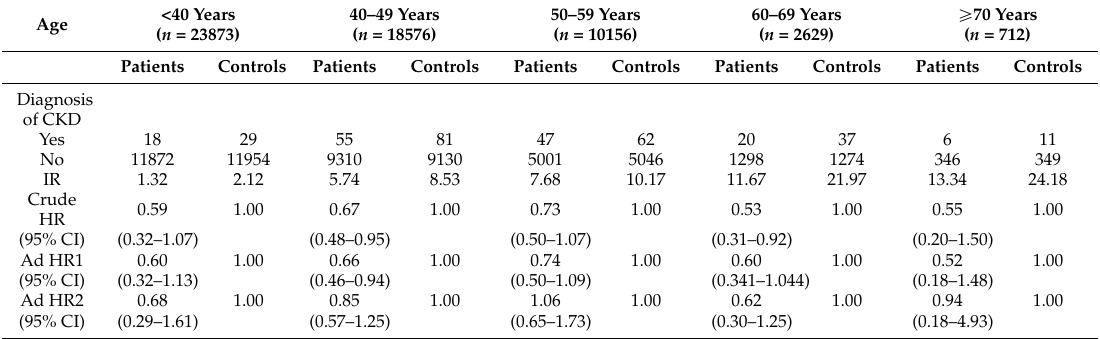
Table 4. Incidence and crude and adjusted risk of chronic kidney disease, according to age.